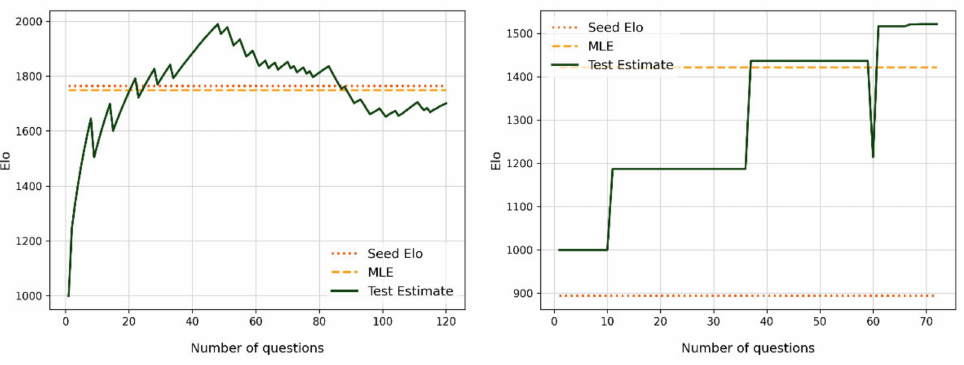
Figure 2. Item Elo rating estimation approaching MLE estimation, on the left. On the right, student’s topic knowledge